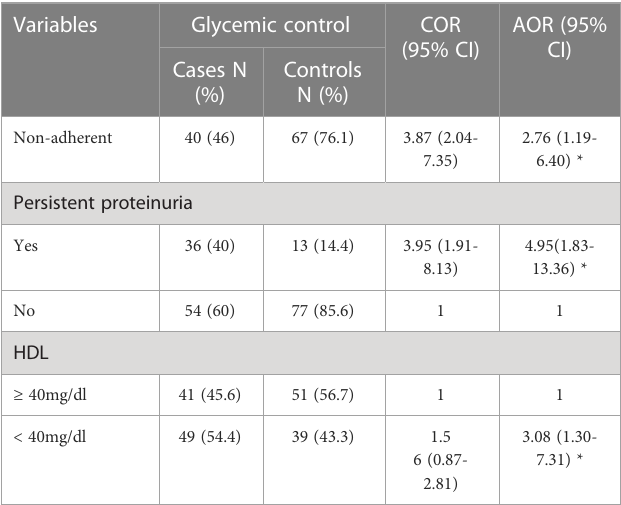
TABLE 6 Predictors of poor glycemic control among type 2 diabetes mellitus patients at DM clinic of UoGCSH, Northwest Ethiopia, 2020